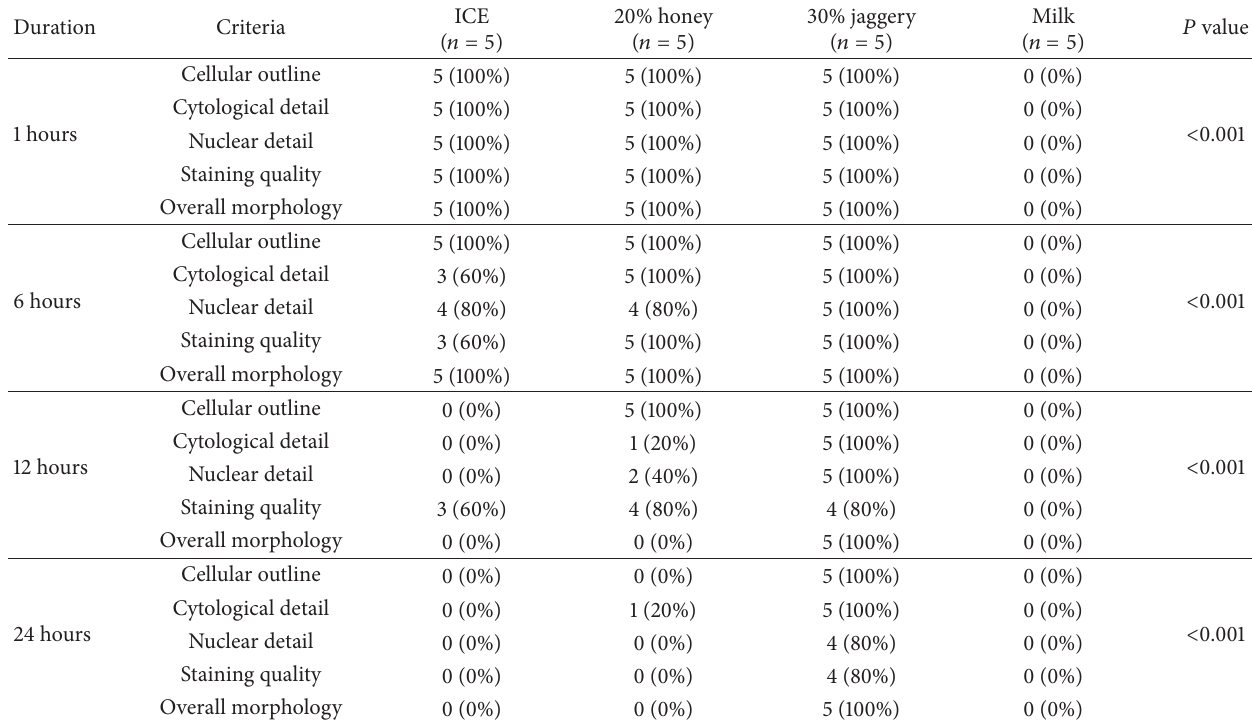
Table 2: Summary of the results after evaluation of the tissues placed in various solutions for specific amounts of time (only cases scoring good and excellent were